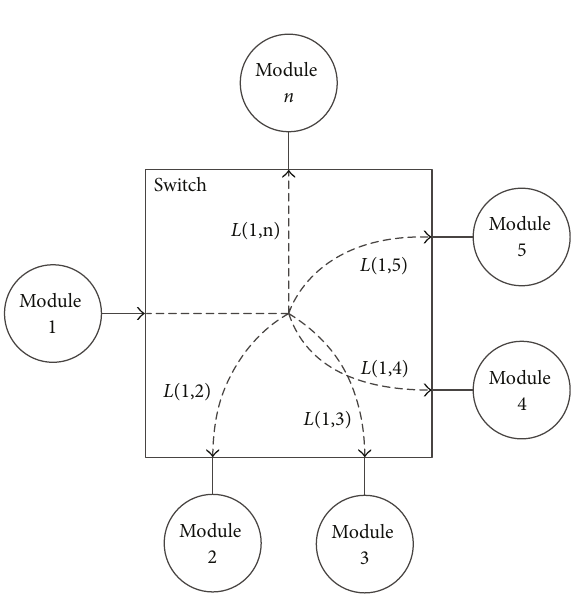
Figure 7: Error output and input model of hardware.